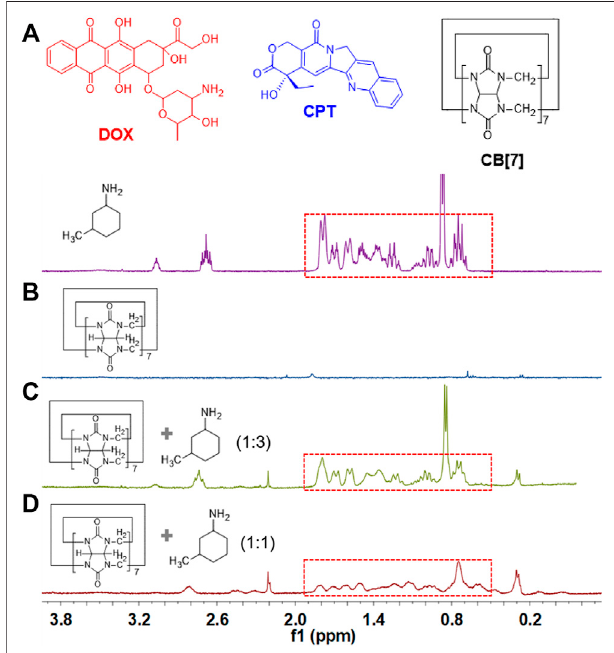
FIGURE1| ChemicalstructureofDOX,CPT,andCB[7].Partial 1 HNMR spectra (D 2 O, room temperature, 400 MHz): (A) 3-methylcyclohexylamine (isomer form), (B) CB[7], (C) CB[7] and 3-methylcyclohexylamine (molar ratio: 1 : 3), and (D) CB[7] and 3-methylcyclohexylamine (molar ratio: 1: